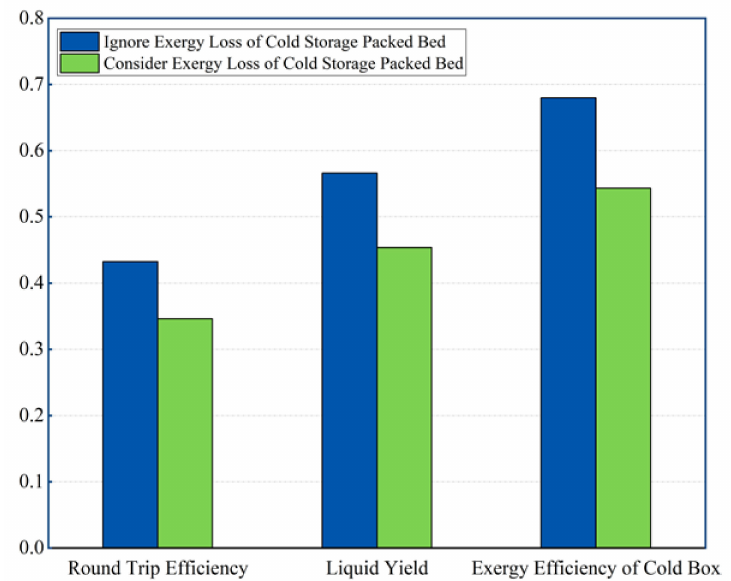
Figure 15. Thermodynamic performance with/without exergy loss of the